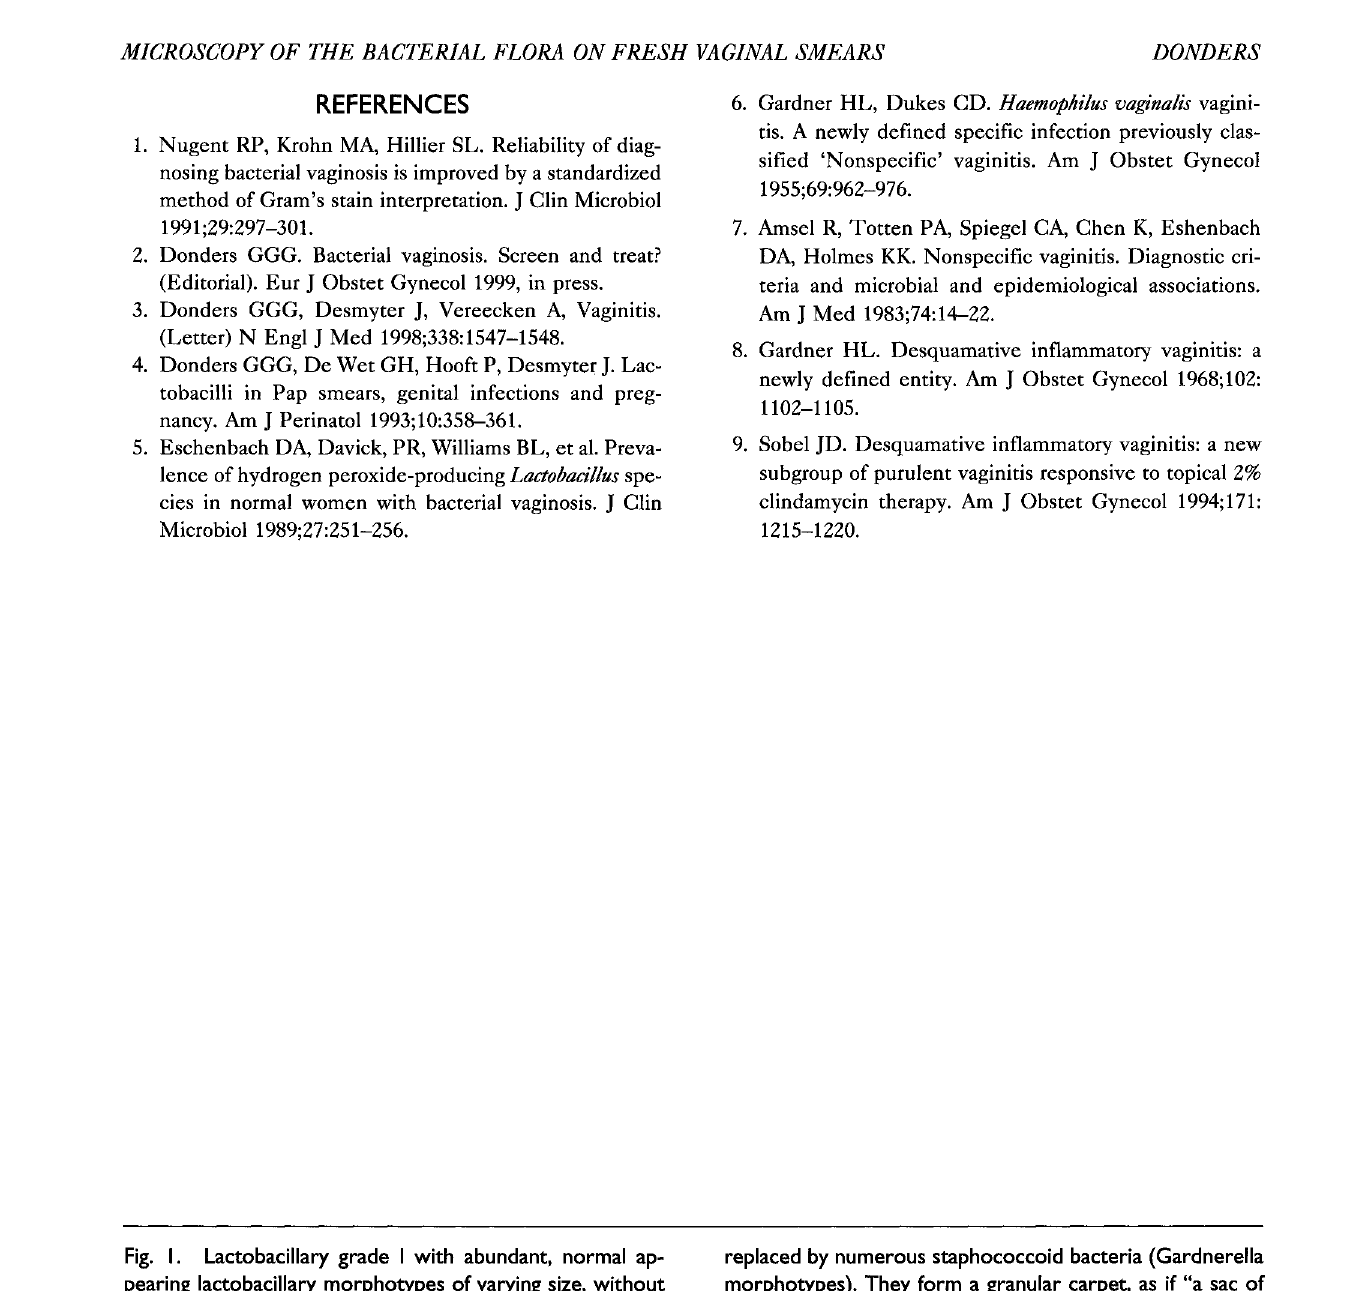
Fig. I. Lactobacillary grade with abundant, normal ap- pearing lactobacillary morphotypes of varying size, without other bacteria. Fig. 2. Lactobacillary grade with abundant, normal ap- pearing lactobacillary morphotypes of varying size, in the presence of numerous cytoplasma organelles and nuclei de- rived from lysed epitheliocytes. The former may not be confused with coccoid bacteria, the latter not with leuco- cytes, both of which are infrequent in this slide. Fig. 3. Lactobacillary grade Ila. Although the lactobacillary morphotypes are the predominant microbial flora, other bacteria are also frequently seen. Fig. 4. Lactobacillary grade lib. Although the lactobacillary morphotypes are evident, they are outnumbered by other coccoid bacteria. Fig. 5. any, lactobacillary morphotypes are seen, all of them being